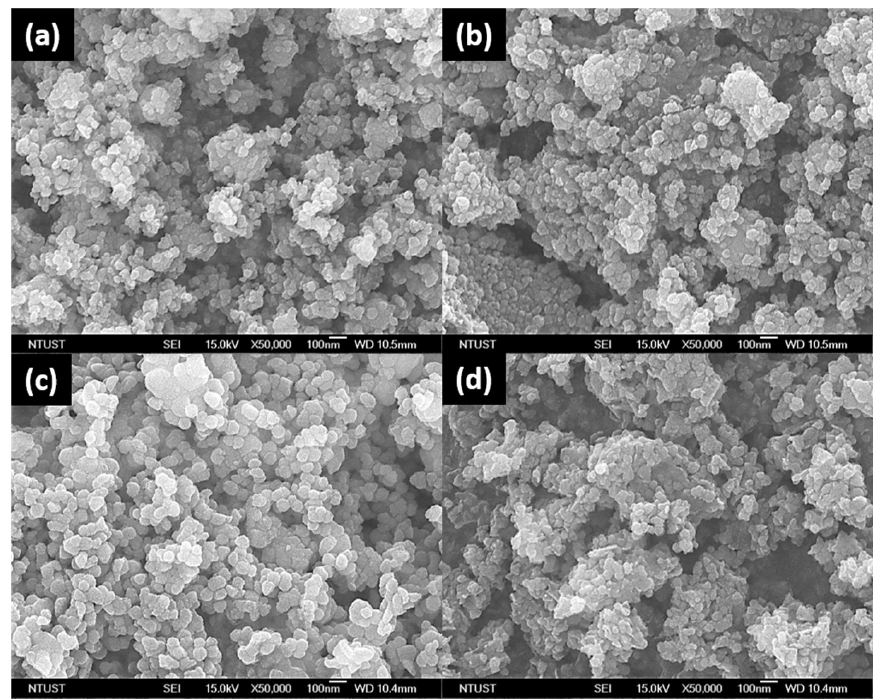
Figure 2. The SEM images for different ratios between iron and cobalt precursors. ( a ) Co-Fe 2 O 3 (20:3), ( b ) Co-Fe 2 O 3 (40:3), ( c ) Co-Fe 2 O 3 (60:3), and ( d ) Co-Fe 2 O 3 (80:3). ( b ) Co-Fe 2 O 3 (40:3), ( c ) Co-Fe 2 O 3 (60:3), and ( d ) Co-Fe 2 O 3